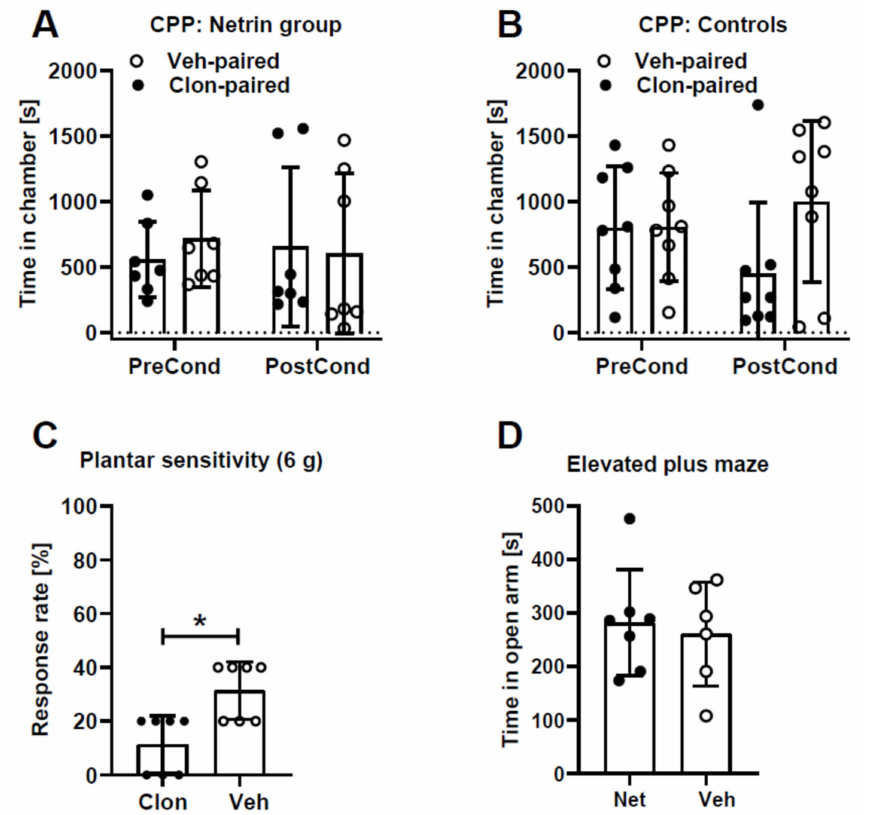
Figure 3. Clonidine-induced effect on conditioned place preference (CPP) in animals treated with netrin-1 ( A ) or vehicle ( B ), and on mechanical hypersensitivity following netrin-1 treatment ( C ). The time spent in the open arm of the elevated plus maze in animals treated with netrin-1 or vehicle ( D ). In ( A , C ), all animals were three weeks earlier treated intrathecally with 2.0 µ g of netrin-1. Clon = clonidine (10 µ g), Veh = vehicle (in ( C ), administered 15 min earlier; in ( D ), administered three weeks earlier), PreCond = before conditioning, PostCond = after conditioning, Net = netrin-1 (2.0 µ g administered three weeks earlier). In ( A ,C,D), n = 7. In ( B ), n = 8. Error bars represent S.D. * p < 0.05 (paired t